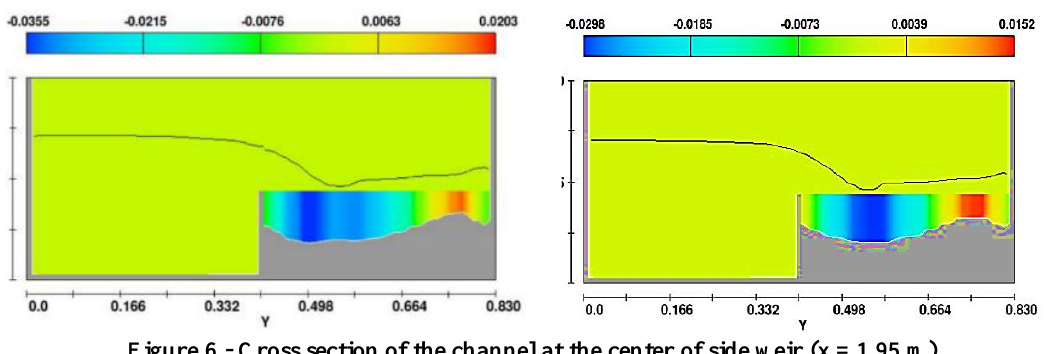
Figure 6.- Cross section of the channel at the center of side weir (x = 1.95 m)